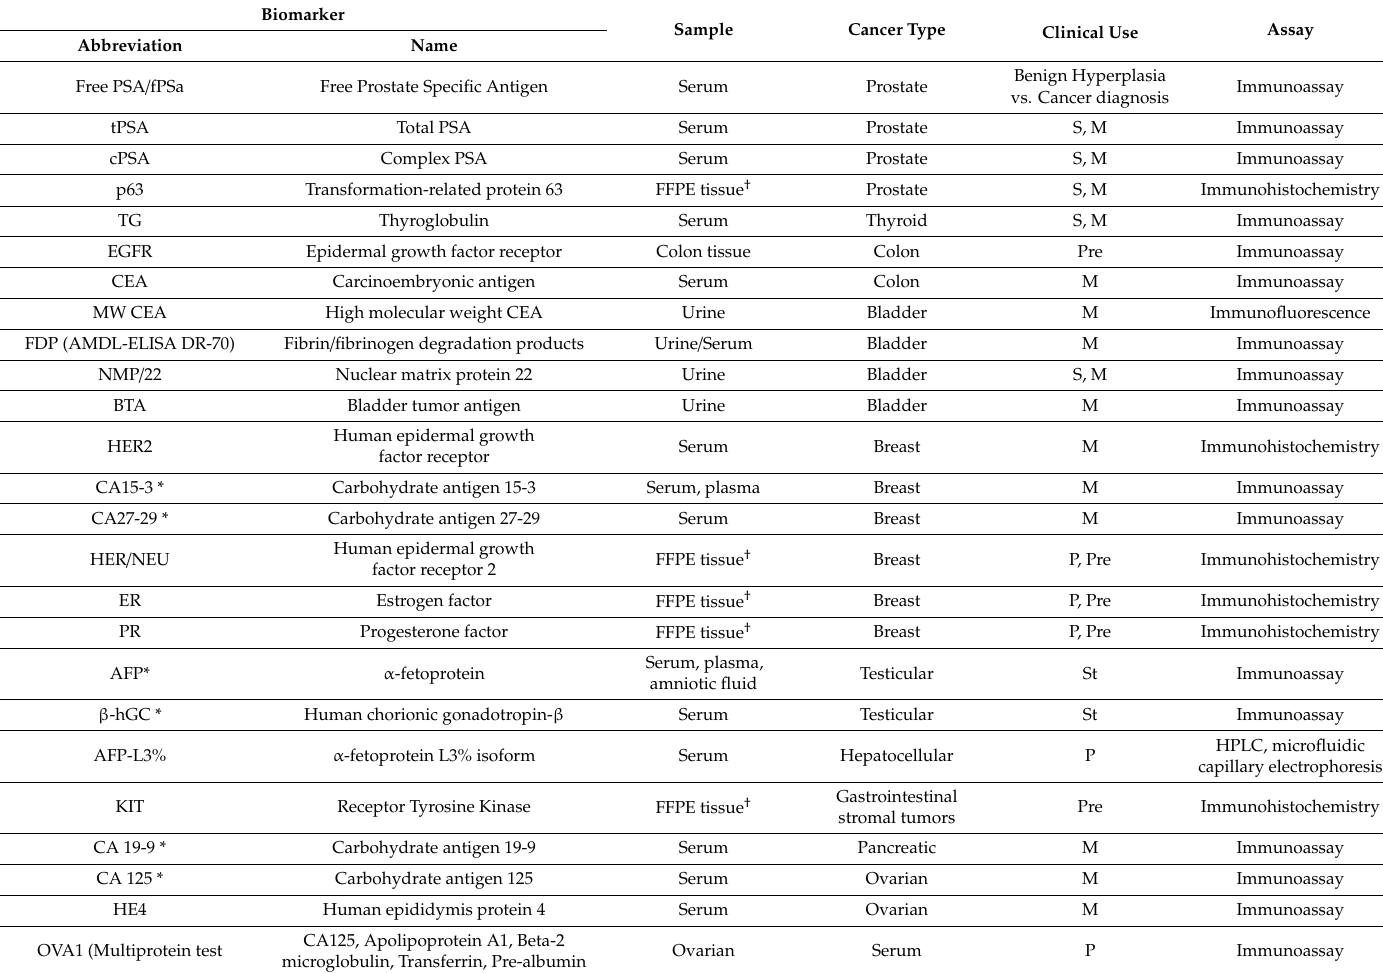
Table 1. FDA approved protein biomarkers